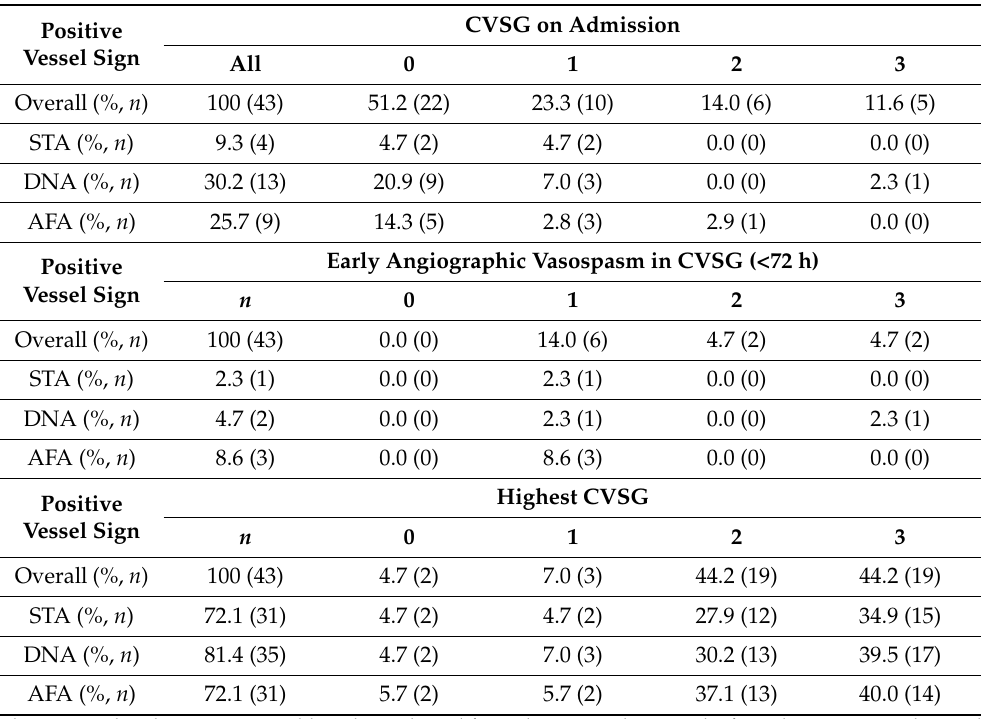
Table 2. Vessel signs in cerebral